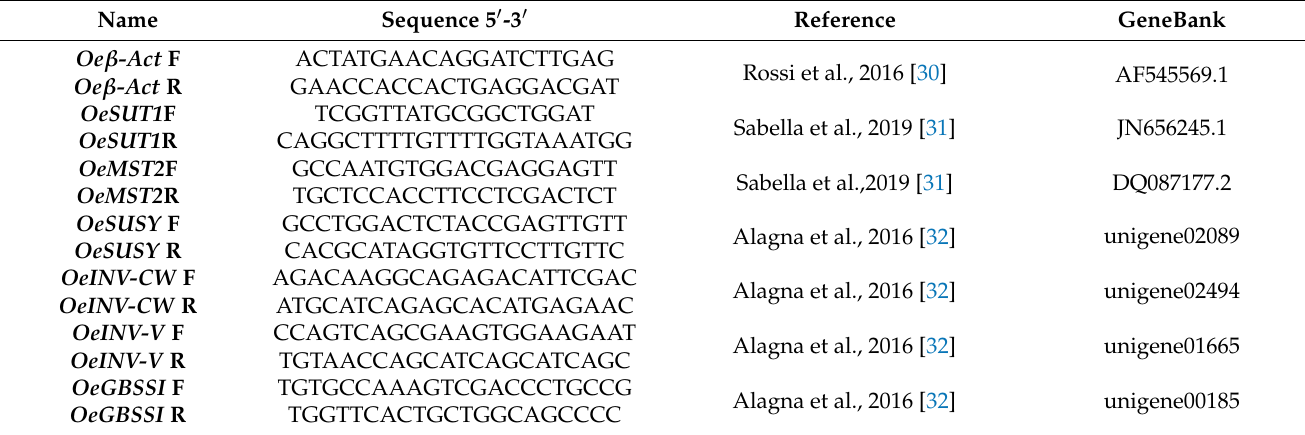
Table 1. List of primers used for real-time